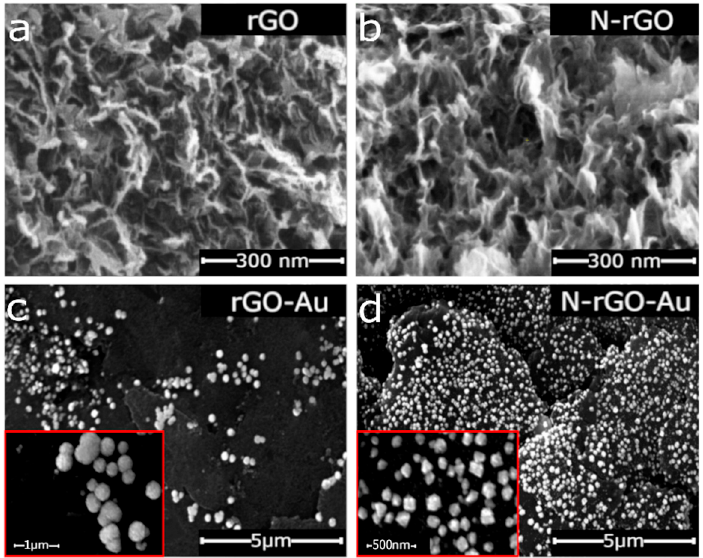
Figure 1. FESEM images of ( a ) rGO, ( b ) N-rGO, ( c ) rGO-Au, and ( d ), N-rGO-Au. Insets on ( c , d ) show enlarged areas of the corresponding materials containing AuNPs.